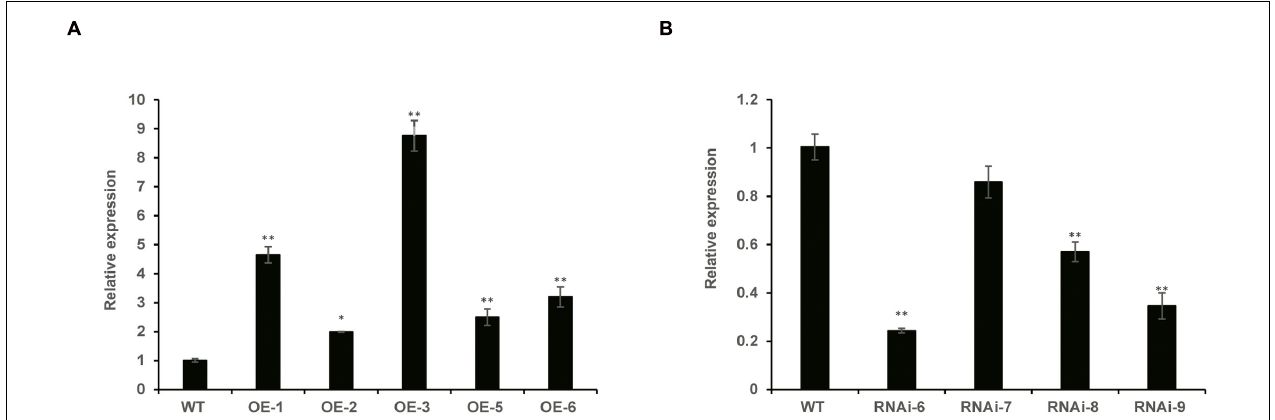
FIGURE 1 | The relative expression of TaNRX1 in transgenic wheat. (A) The relative expression of TaNRX1 in overexpression lines ( n = 3). (B) The relative expression of TaNRX1 in RNA interference lines ( n = 3). Data represent the mean ± SD. WT, wild type; OE-1-OE-6, TaNRX1 overexpression T 3 homogeneous lines; RNAi-6–RNAi-9, TaNRX1 RNA interference T 3 homogeneous lines. * P < 0.05, ** P < 0.01 represent significant difference between the transgenic line and the WT,